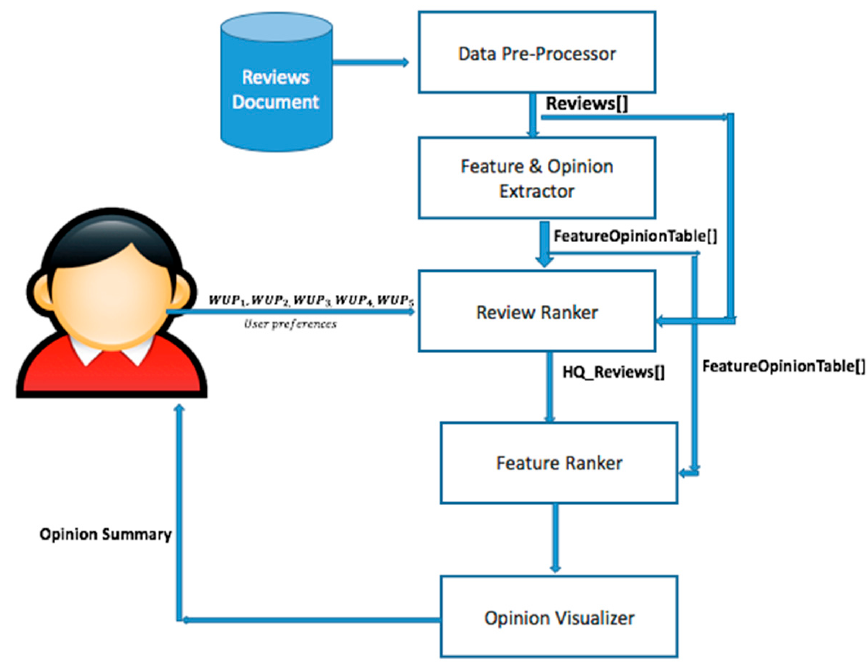
Figure 6. Architecture of proposed system.